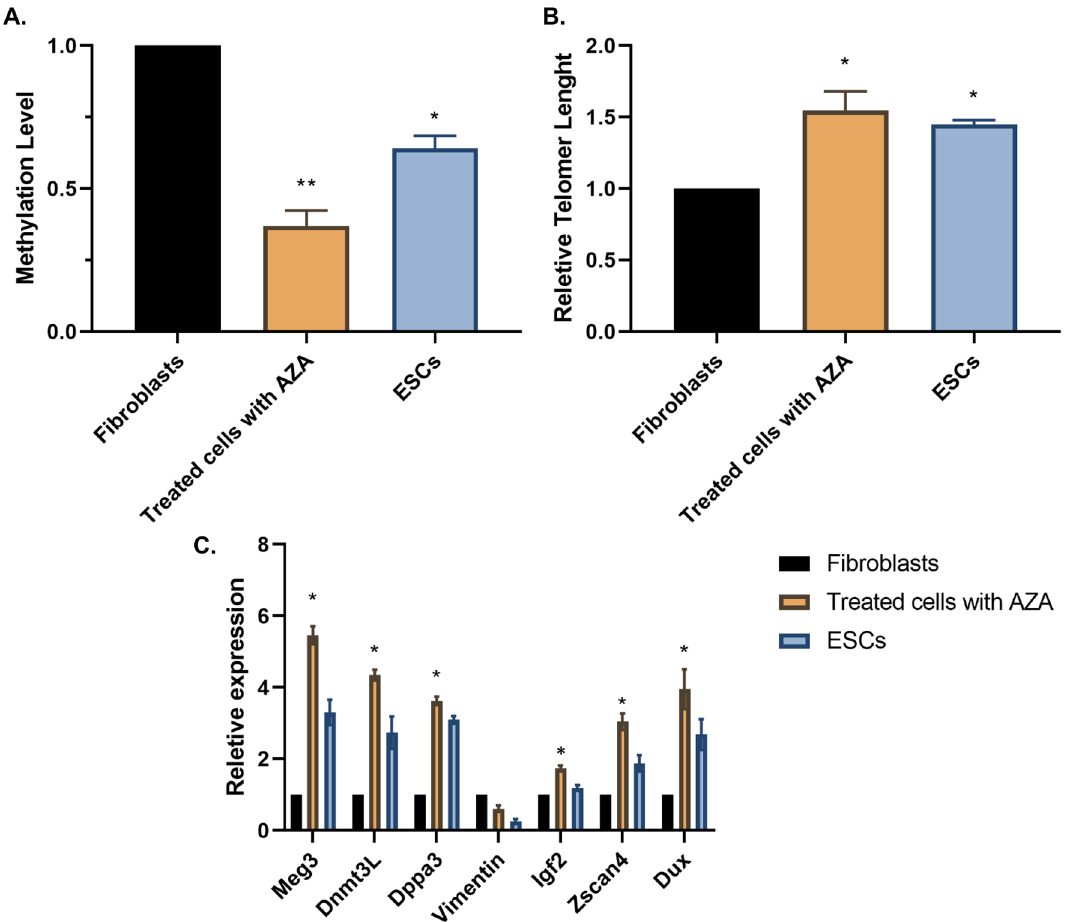
Figure 2. Molecular characterization of iTots shows overexpression of totipotent-related genes. ( A ) Aza- treated cells have lower DNA methylation levels in sorted cells versus untreated cells (*P < 0.05, **P < 0.01). ( B ) Telomere of Aza-treated cells increases in comparison with fibroblasts (*P < 0.05). ( C ) Gene expression analysis of iTots show their potential totipotent state comparing with fibroblasts and ESCs (*P <